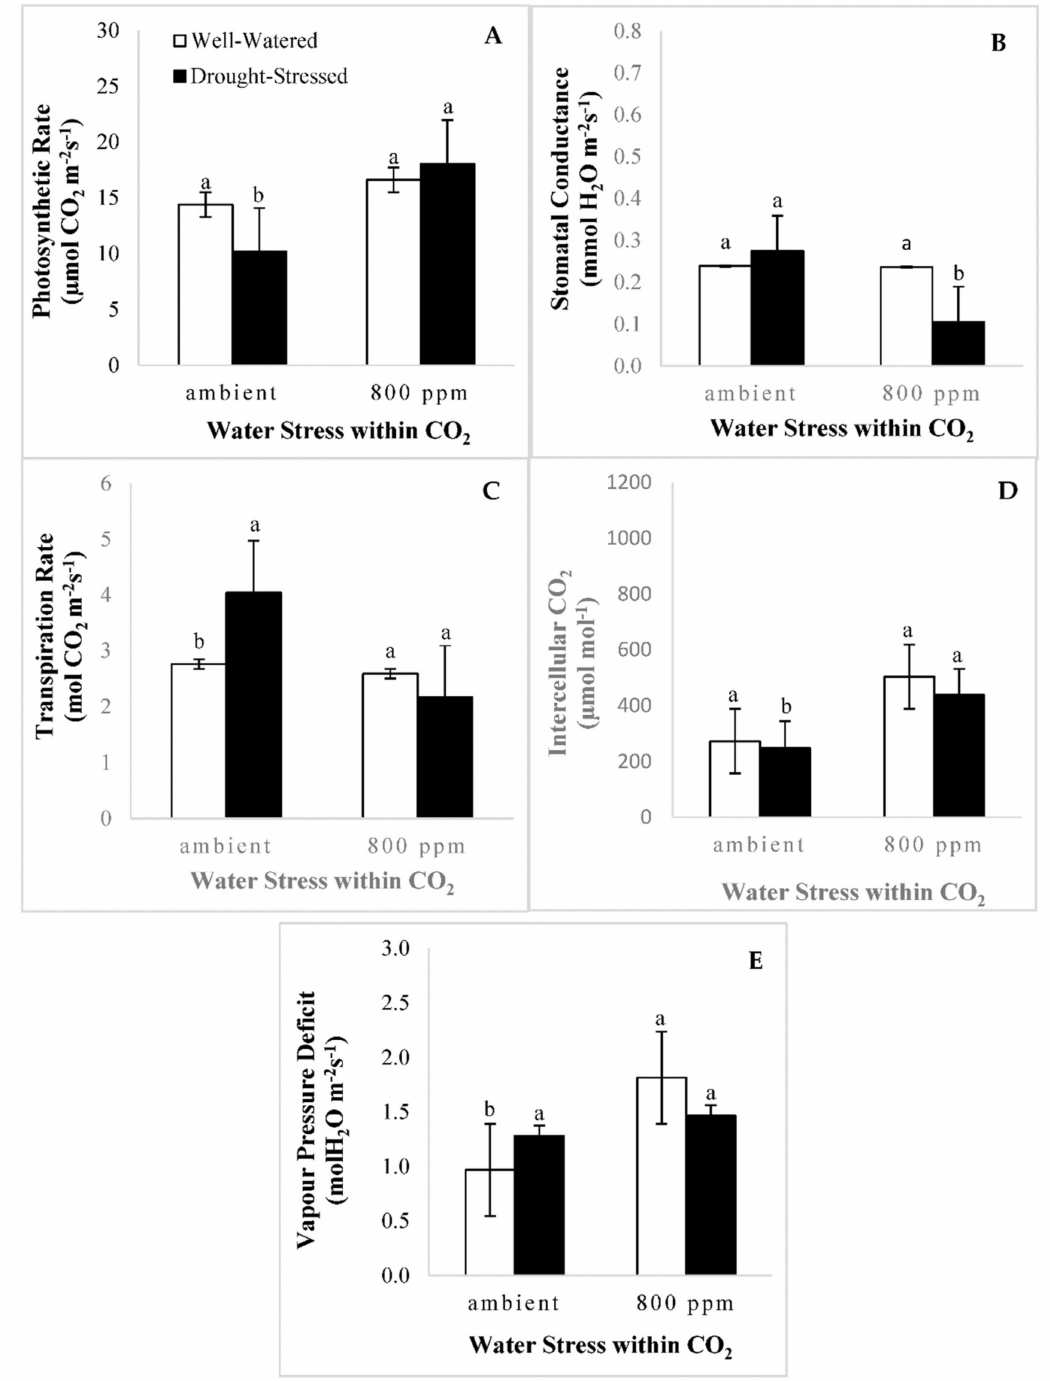
Figure 1. Effect of water stress within CO 2 levels on Ficus sp. with brassinolide application according to parameters: ( A ) at first month after treatment (MAT), ( B ) gs at second MAT, ( C ) E at second MAT, ( D ) Ci at second MAT, and ( E ) VPD at third MAT. Bars represent means ± SD. Bars with different letters were significantly different by Fisher’s LSD at p <